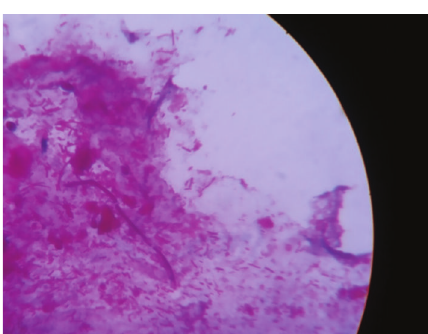
Figure 2: Direct gram staining showing the presence of gram positive